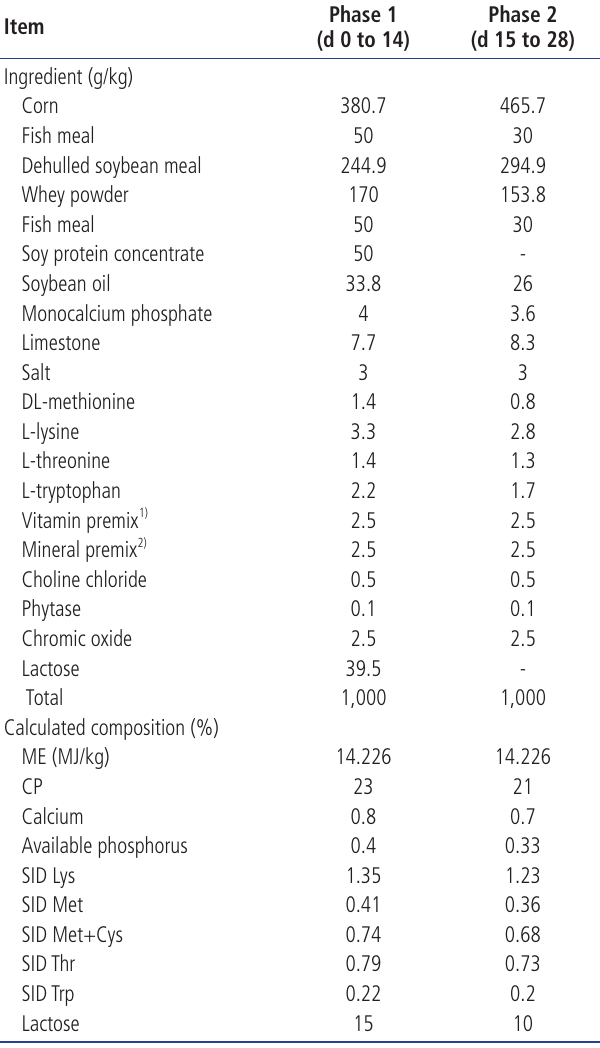
Table 1. Formula and chemical composition of control diets (as-fed basis)